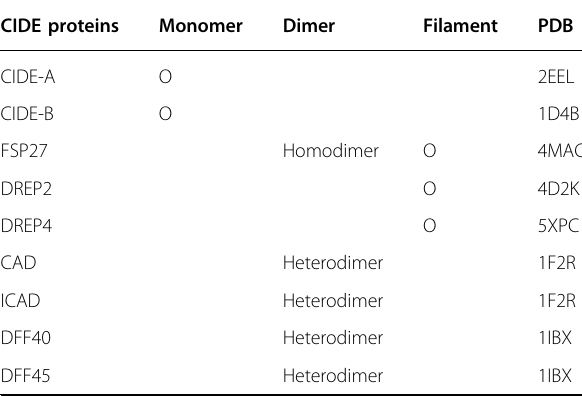
Table 2 Structures of various forms of CIDE